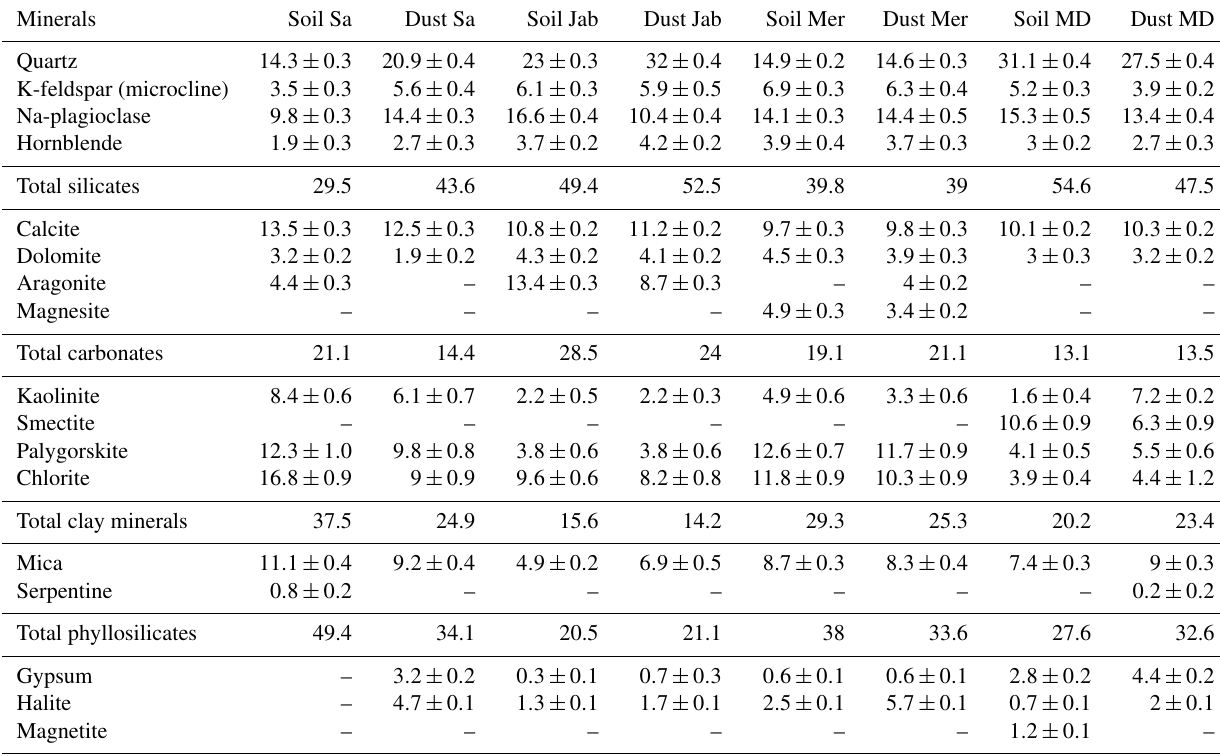
Table 3. Mineralogical composition of natural soil and dust samples in percent, derived from Rietveld analysis of the XRD patterns (after Hamzehpour et al.,